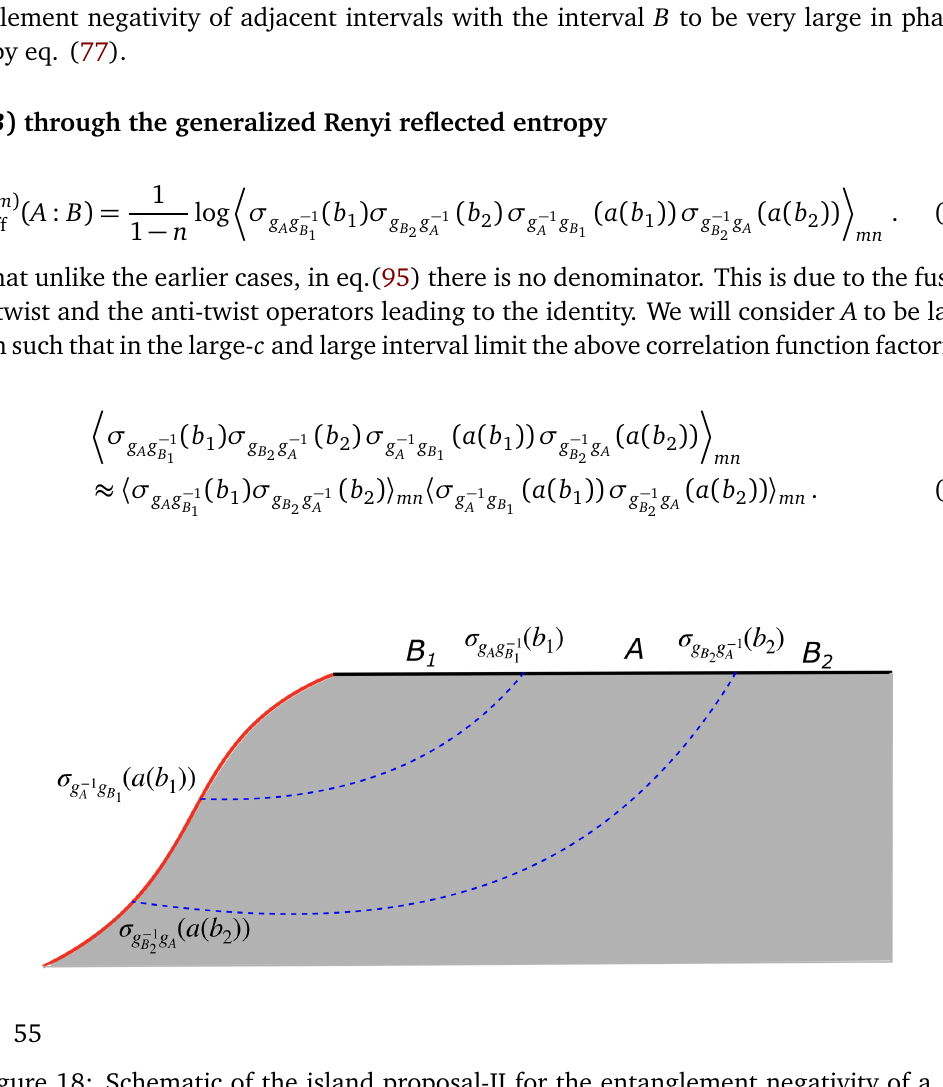
Figure 18: Schematic of the island proposal-II for the entanglement negativity of a single interval in